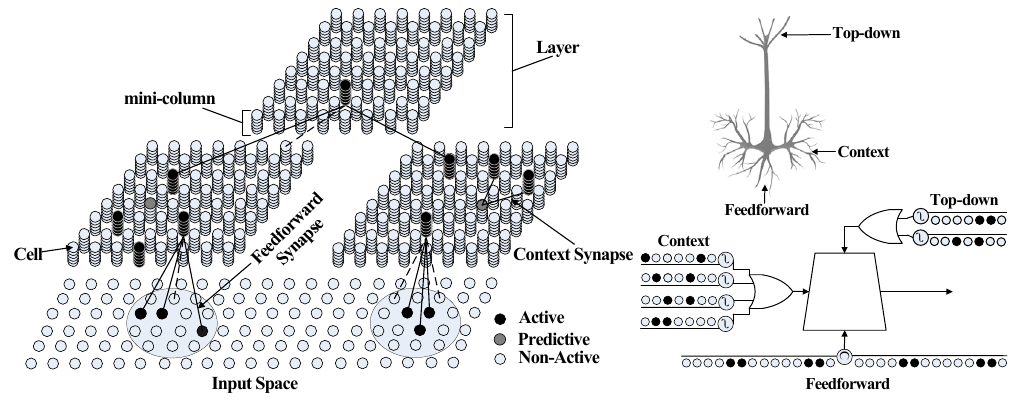
Figure 6. Illustration of retrieval using Gait SDRs.